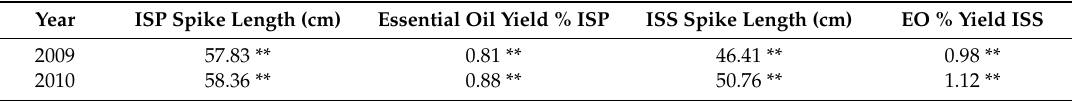
Table 5. Average annual production parameters–floral spike principal stem (ISP) and secondary stem